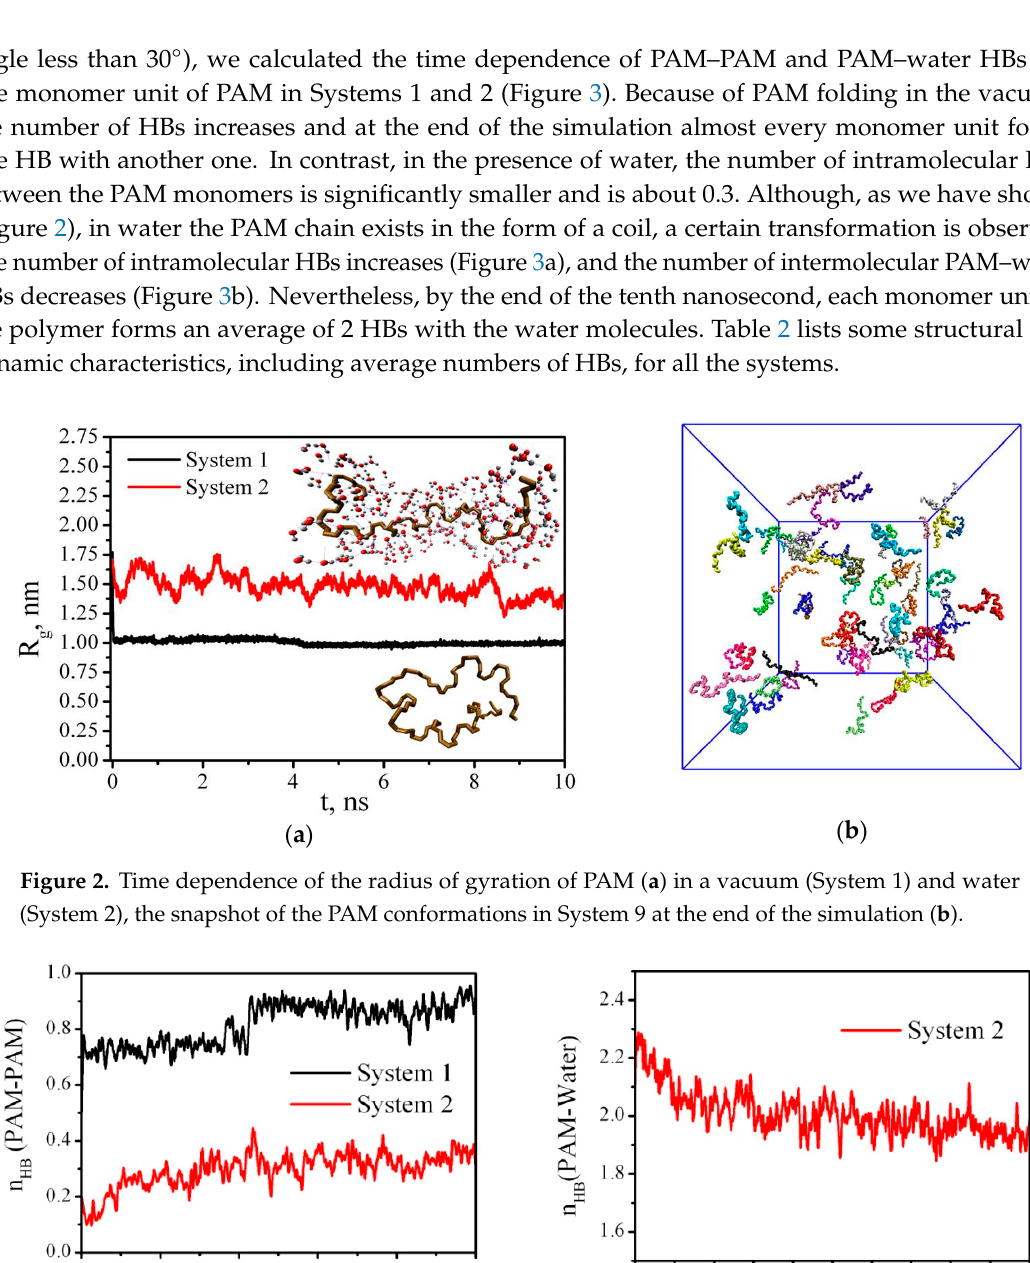
Figure 3. Examples of the time dependence of the number of PAM–PAM ( a ) and PAM–water ( b ) hydrogen bonds (n HB ) per a PAM monomer unit.